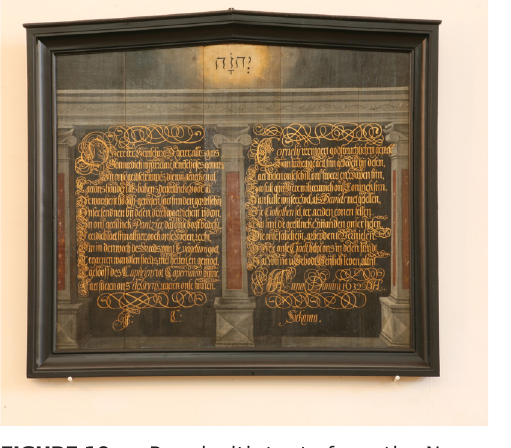
Panel with texts from the New Testament, Sneek, 1632, photo archive Regnerus